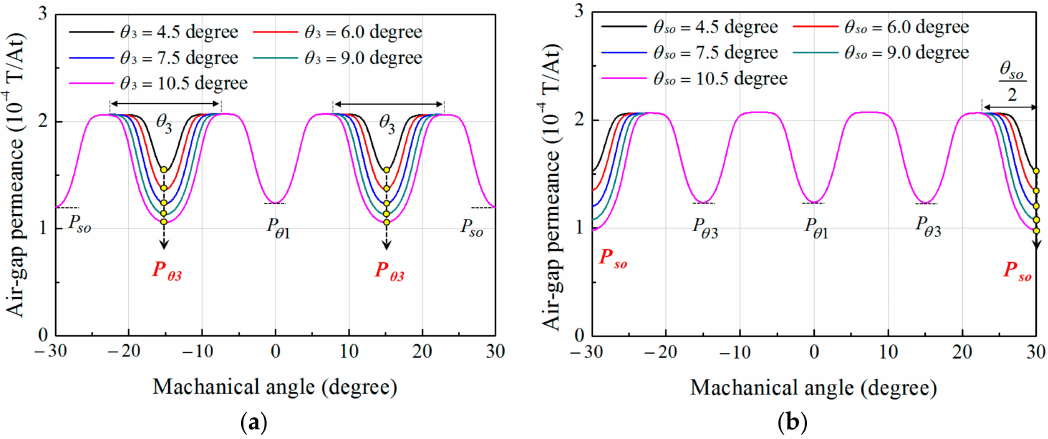
Figure 5. Air-gap permeance distribution. ( a ) According to θ 3 ; ( b ) According to θ so